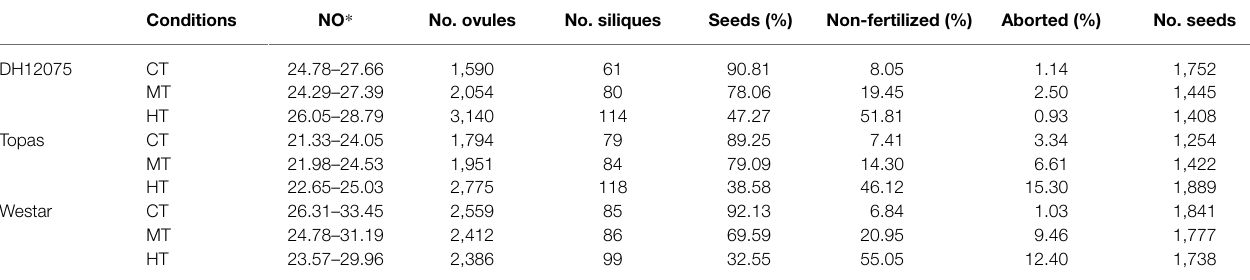
TABLE 1 | Evaluation under the stereomicroscope of the number of ovules, fertilized and unfertilized seeds per silique.